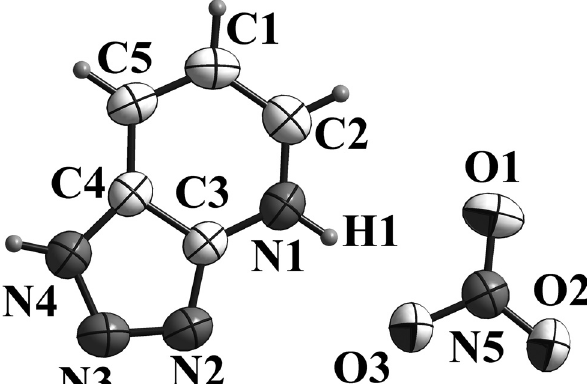
Table  : Data collection and handling.